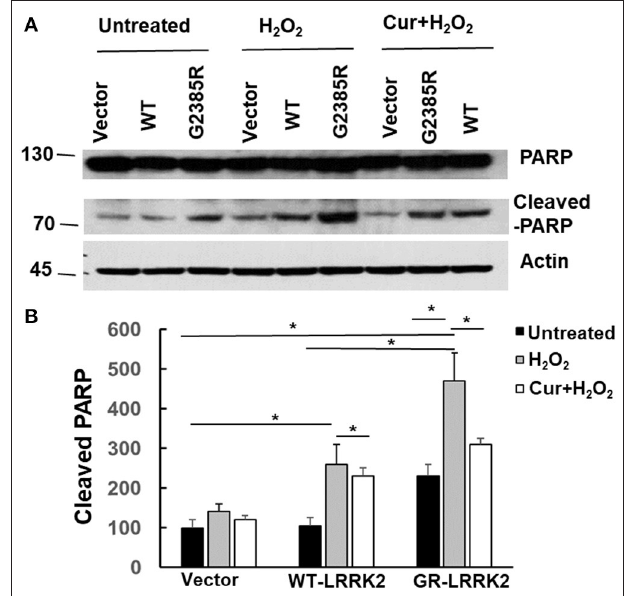
FIGURE 6 | Curcumin reduced H 2 O 2 and G2385R-LRRK2-induced PARP cleavage. HEK293 cells were co-transfected with vector or various LRRK2 constructs with or without a subtoxic dose of H 2 O 2 exposure and curcumin (1 µ M) for 48h. Cell lysates were subjected to western blot analysis using antibodies against PARP, cleavage PARP, and actin. (A) Representative blot from three separated experiments. (B) Quantification of (A) * p < 0.05, statistical significance between groups as